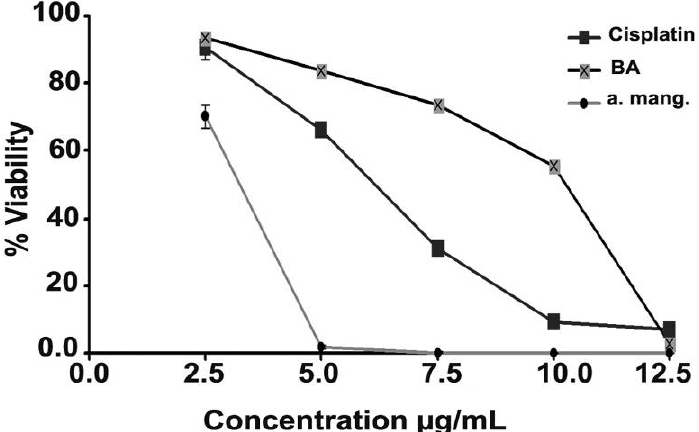
Figure 4. The dose response curves of α -mangostin, BA, and cisplatin on HCT 116